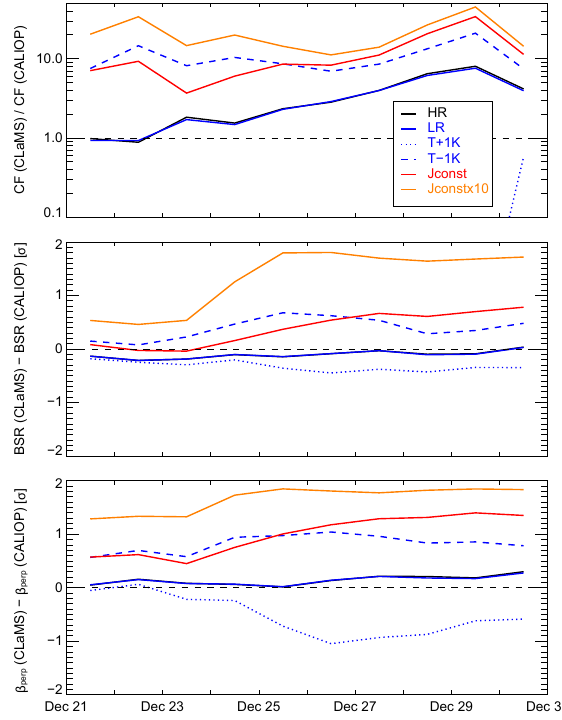
Fig. 8. Comparison of simulated optical properties from CLaMS with CALIOP observations between 21 and 30 December 2009. Upper panel: ratio between observed and simulated cloud fraction (CF) per day. Central panel: point-by-point comparison between CALIOP and CLaMS backscatter ratios (BSR). The level of agree- ment is expressed as daily median value in terms of σ , which is the uncertainty associated to the CALIOP measurement. See main text for a detailed description of σ . Lower panel: same as central panel but for the perpendicular backscatter signal ( β perp ).